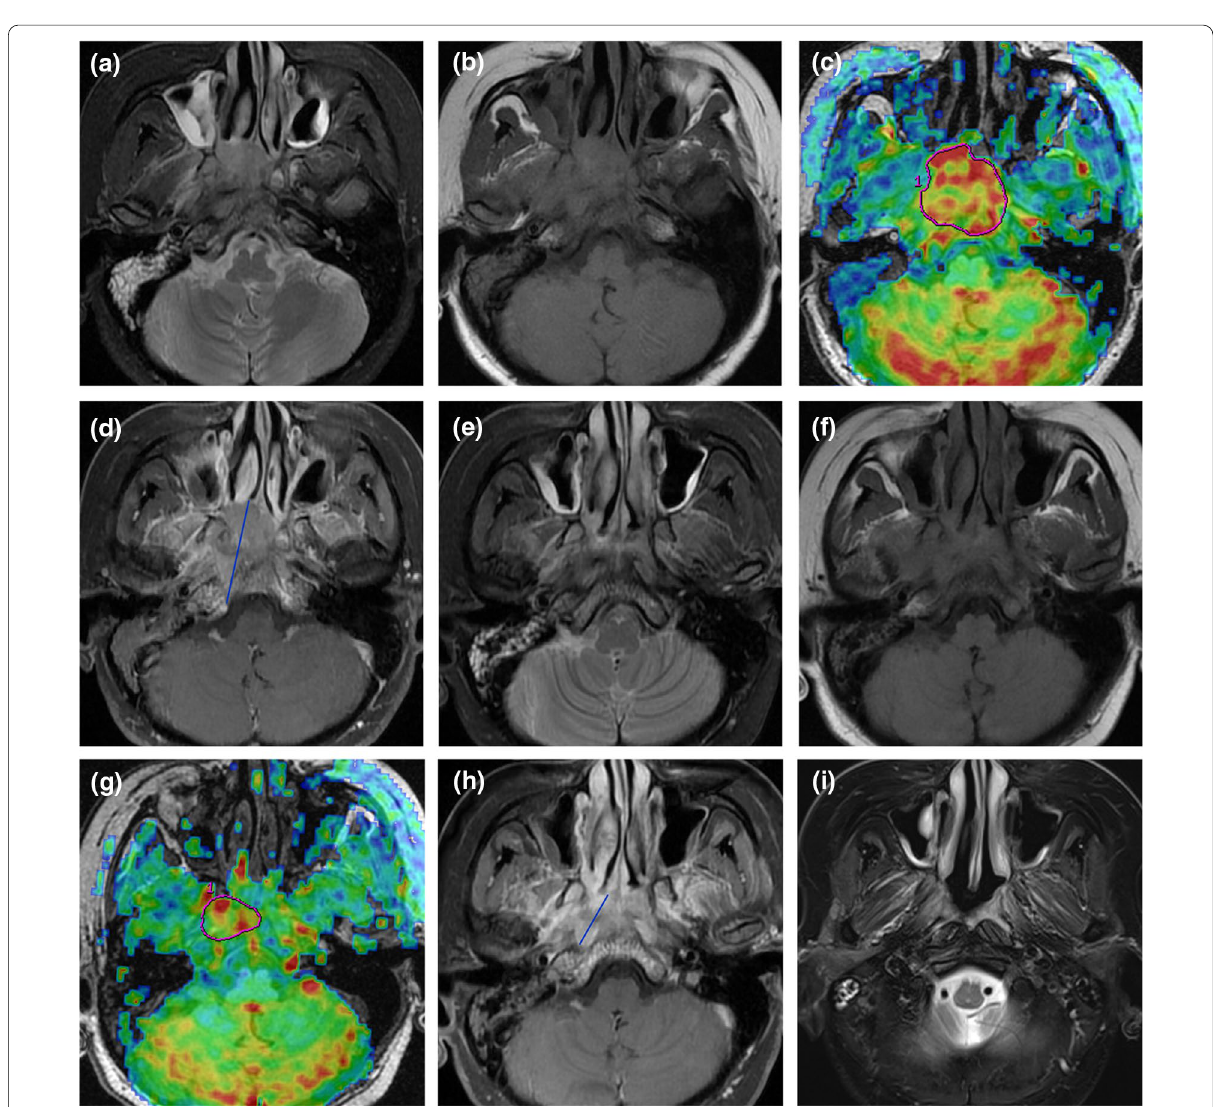
Fig. 4 A male patient aged 48 years with stage IVA nasopharyngeal carcinoma (T4N2MO). Pathological examinations suggested non-keratinizing undifferentiated squamous cell carcinoma. Before treatment, T2-IDEAL and T1WI images revealed nasopharyngeal masses on the right invading the sphenoid sinus ( a and b ); the ASL series integrated with BRAVO series revealed high mass perfusion ( c ) with a TBF value of 170.67 mL 100 g − 1 min − 1 ; the maximum primary tumor diameter measured on axial T1WI enhanced imaging was 45.92 mm ( d ). Re-examinations · · after the prescribed dose reached 40 Gy revealed notable tumor shrinkage ( e and f ) and reduced tumor perfusion ( g ) with a TBF value